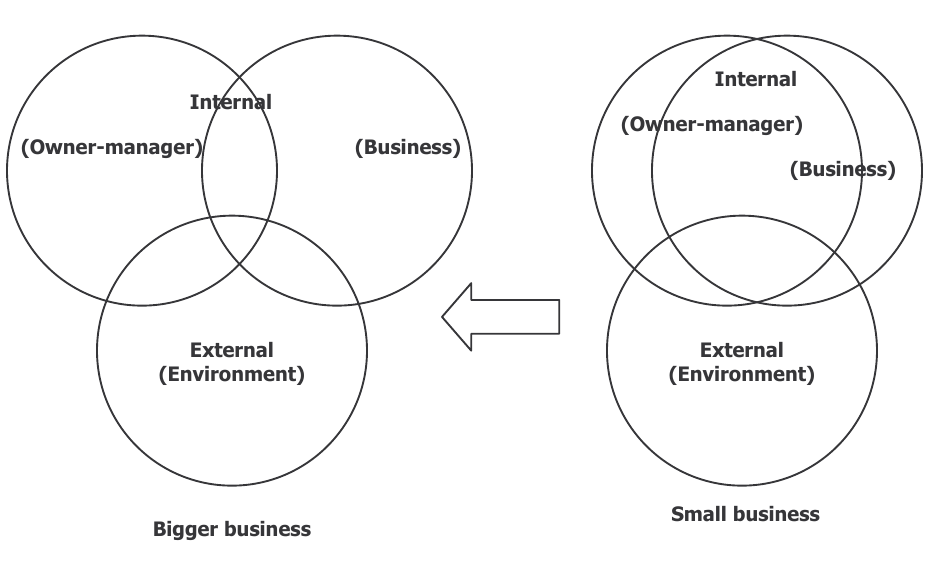
Figure 2: Business system constituents